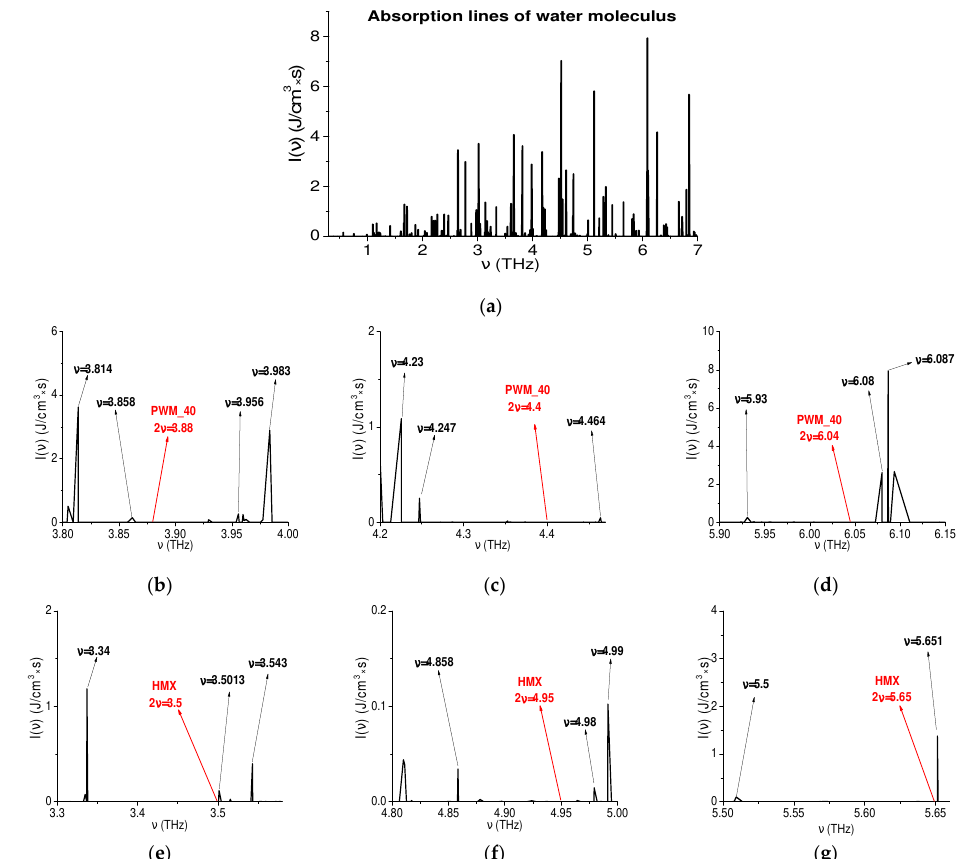
Figure 25. Absorption spectrum of water molecules in the frequency ranges ν = [0.3, 7.0] THz ( a ), [3.8, 4.0] THz ( b ), [4.2, 4.5] THz ( c ), [5.9, 6.15] THz ( d ), [3.3, 3.58] THz ( e ), [4.8, 5.05] THz ( f ), [5.5, 5.65] THz ( g ) and location of the PWM_40 doubled absorption frequencies and those of HMX_STF (red arrows) in these frequency ranges. In Figure 25e–g, the absorption spectrum of water molecules is presented in the short frequency ranges ν = [3.3, 3.58] THz, [4.8, 5.05] THz and [5.5, 5.65] THz, in which the HMX_STF doubled absorption frequencies ν = 3.5, 4.95, 5.65 THz are shown with red ar- rows, respectively. The absorption frequencies of water vapor ν = 3.5013, 4.98, 5.651 THz are closest to them. Their absorption intensities are 0.116, 0.0145 and 1.38 (g) J/cm 3 ∙s Figure